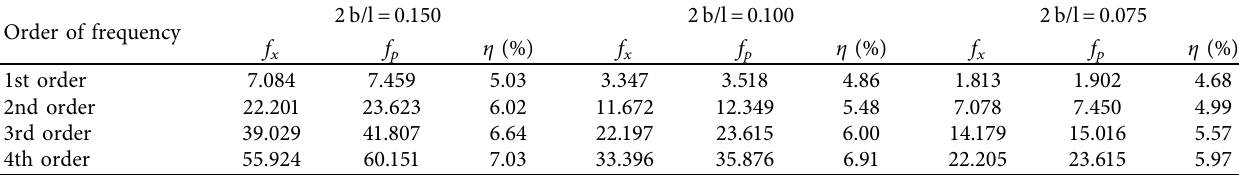
Table 3: Comparison of vibration frequency values of composite box girder with different width to span ratios (Hz). 2b/l � 0.150 Order of frequency